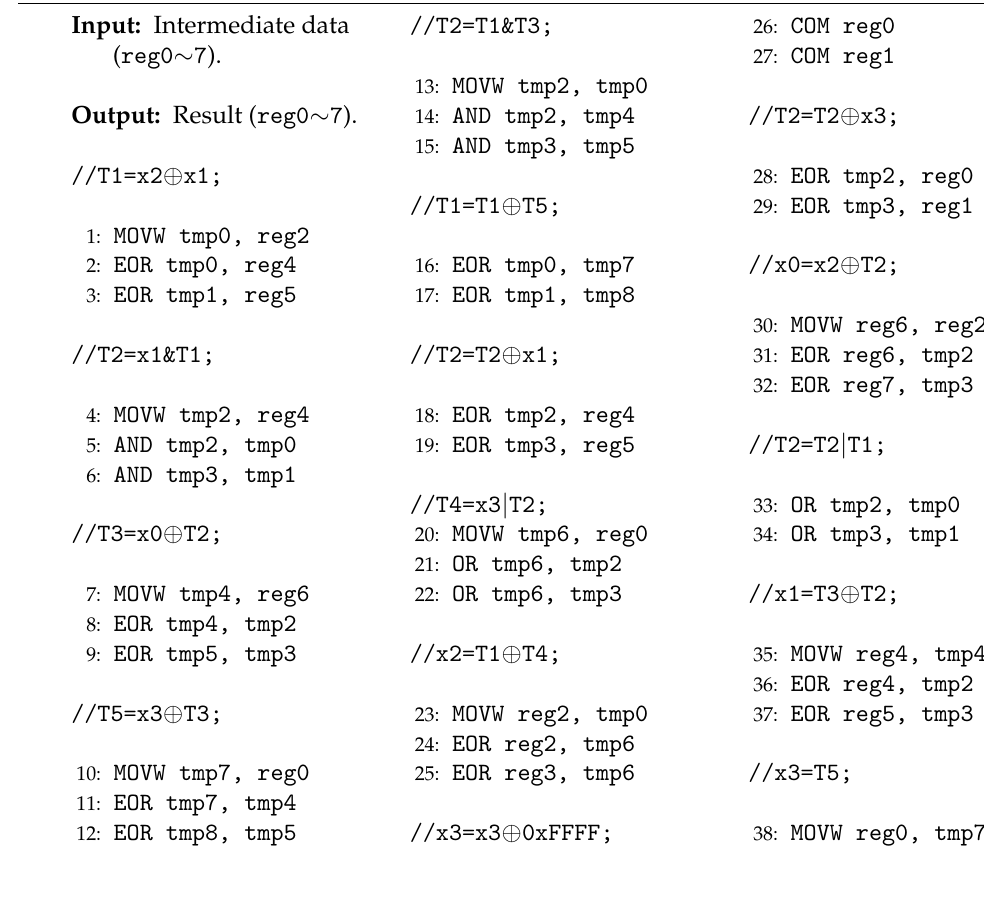
Algorithm 3: Substitution operation in assembly